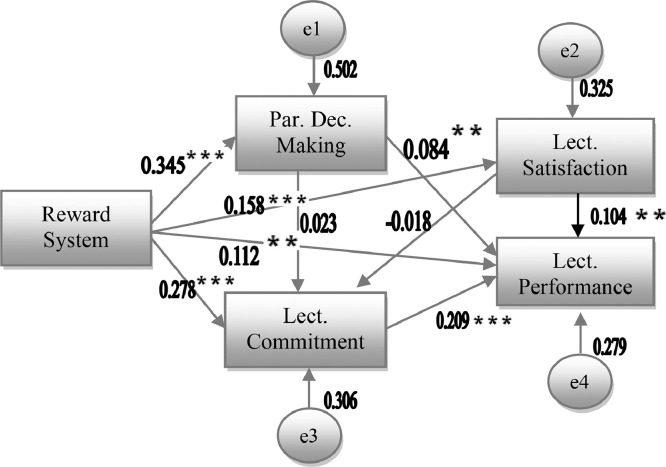
Revised Model based on Lecturer Performanceχ2  =  0.104; p  =  0.747; GFI  =  1.000; AGFI  =  0.998; RMSEA  =  0.000*= p  <  0.10; **= p  <  0.050; ***= p  <  0.001